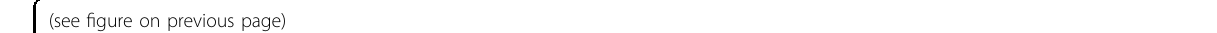
Fig. 2 Modeling different levels of TRPM8 in RWPE-1 and LNCaP FGC prostate cell lines. a Western blot analysis and quanti fi cation of full-length 6TM TRPM8 amount in RWPE-1 and LNCaP FGC cell lines expressing endogenous (WT), overexpressed (M8) or knocked-out (CAS) levels of the protein. b Immuno fl uorescence analysis and quanti fi cation of PM-associated full-length 6TM TRPM8 in RWPE-1 and LNCaP FGC cell lines with endogenous (WT), overexpressed (M8), or knocked-out (CAS) levels of the channel. For quanti fi cation of PM TRPM8 positive cells a total of 6000 cells were counted from different fi elds. Scale bar, 5 μ m. c – e Morphology ( c ), growth ( d ), and cell death ( e ) analyses of RWPE-1 and LNCaP FGC cell lines with endogenous (WT), overexpressed (M8), or knocked-out (CAS) levels of TRPM8. Error bars, mean ± SD. Experiments were performed in triplicate; data were analyzed using a two-tailed Student ’ s t -test. ** P ≤ 0.01; *** P ≤